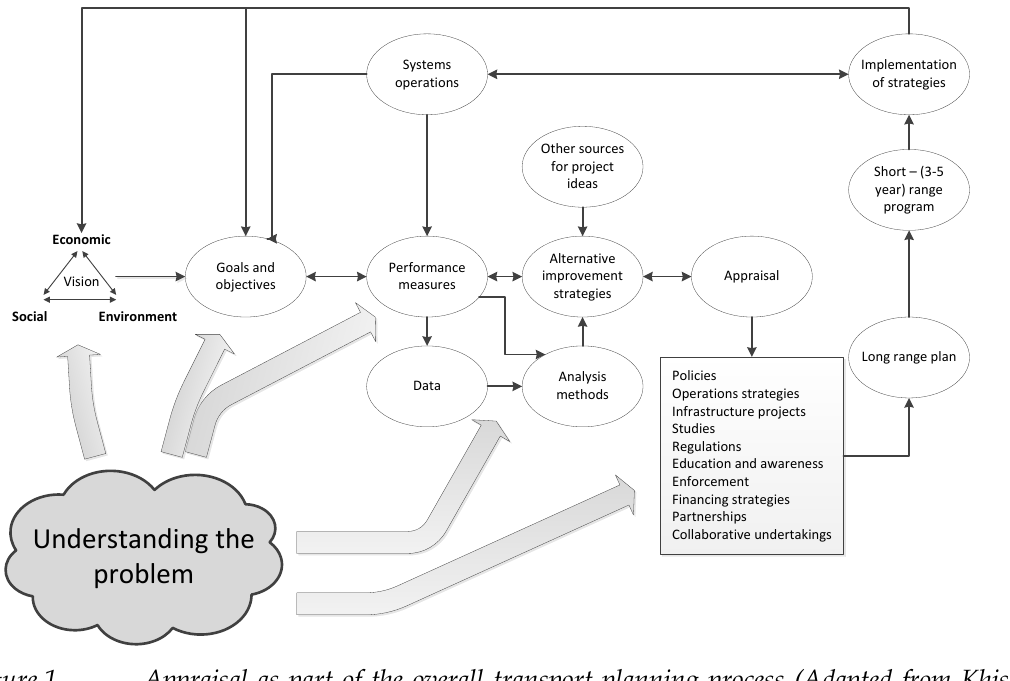
Figure 1. Appraisal as part of the overall transport planning process (Adapted from Khisty et al.,